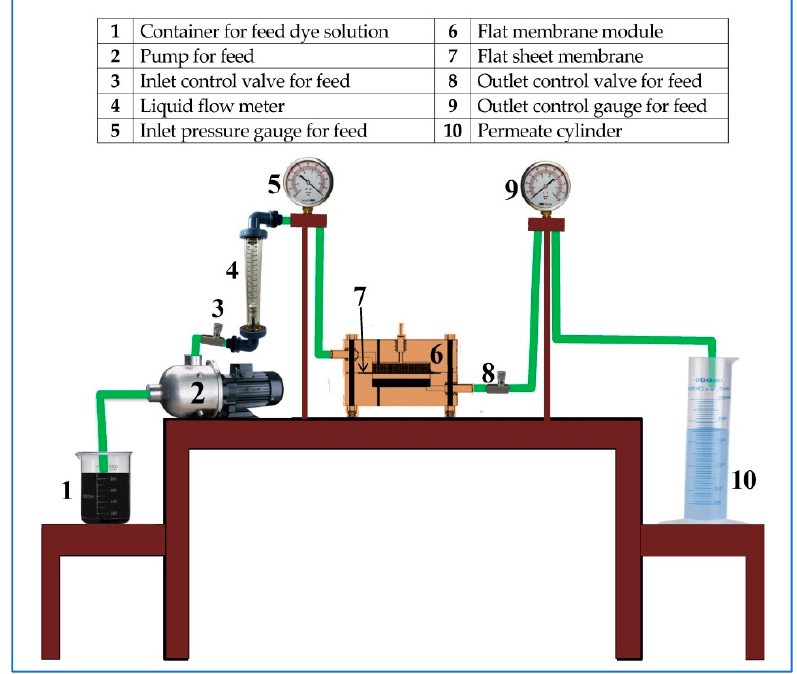
Figure 1. Schematic diagram of the cross ‐ flow filtration rig.